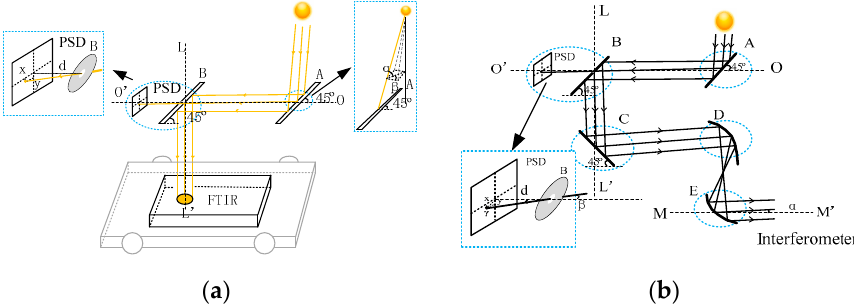
Figure 1. ( a ) The schematic diagram of SOF-FTIR system. ( b ) The external light path of FTIR.